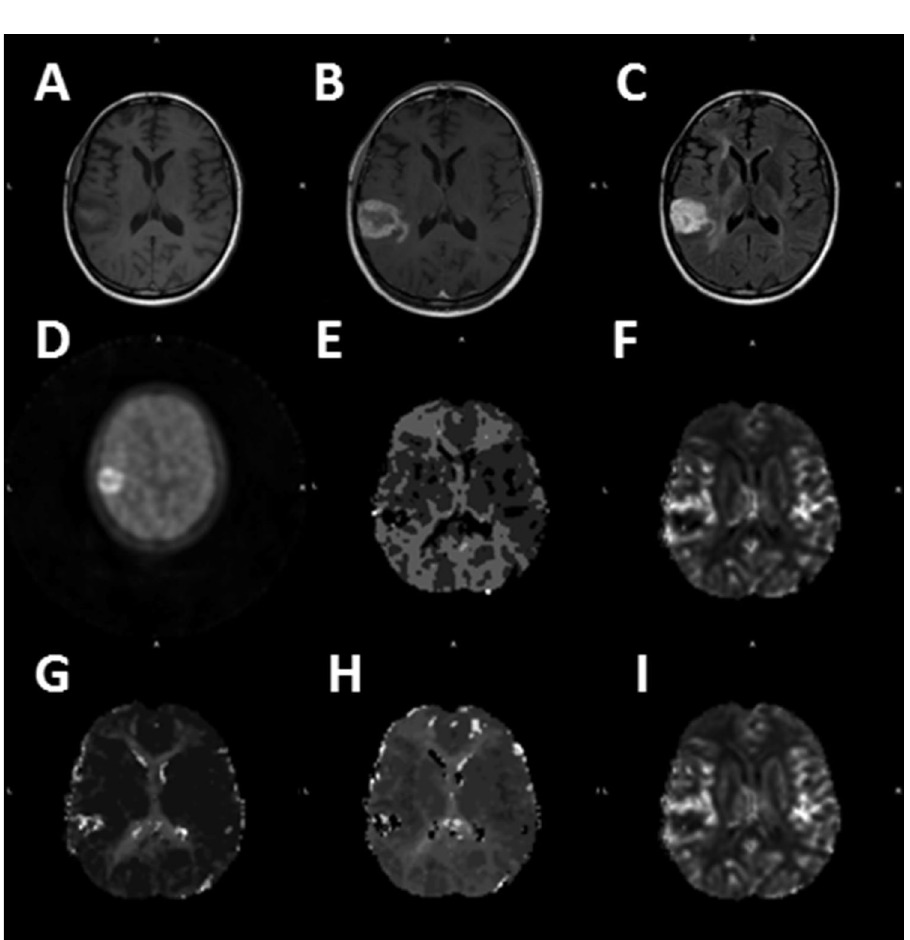
Figure 1. Representative images at baseline (Case UT003). ( A) pre-contrast T1, ( B) post-contrast T1, ( C) FLAIR, ( D) 18 F-FMISO PET, ( E) MTT, ( F) srCBV, ( G) Tmax, ( H) TTP, ( I)